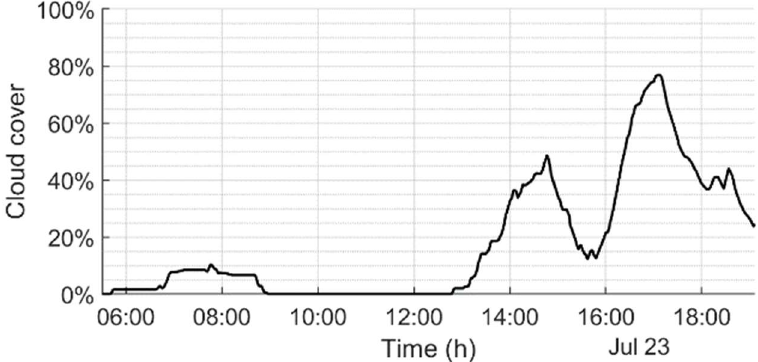
Figure 9. Cloud cover percentage on 23rd July.